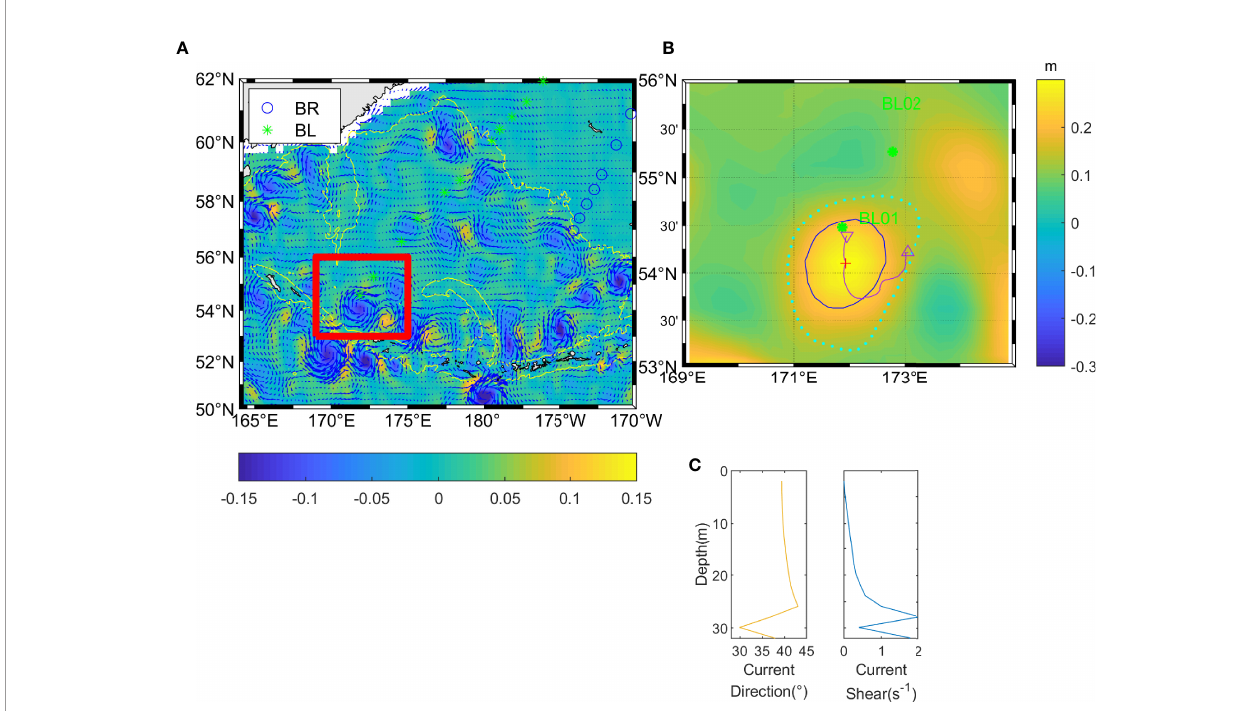
FIGURE 6 | (A) The vectors represent the surface geostrophic fl ow anomaly. The color denotes the vertical relative vorticity (normalized by the local planetary vorticity f) at the sea surface. The yellow solid lines denote the 2000-m isobaths. The red rectangle is the location of subplot (B) . (B) The anticyclonic eddy next to station BL01 [the red rectangle in subplot (A) ]. The contours denote the sea surface height from satellite observations. The red plus sign, blue solid line, cyan dotted line, and purple solid line are the center, max speed shape, effective contour shape, and track of the eddy. The upward-pointing triangle and downward-pointing triangle are the center of the eddy on June 1 and September 30, respectively. (C) The vertical distribution of the current direction and vertical current shear at BL01 from ADCP.